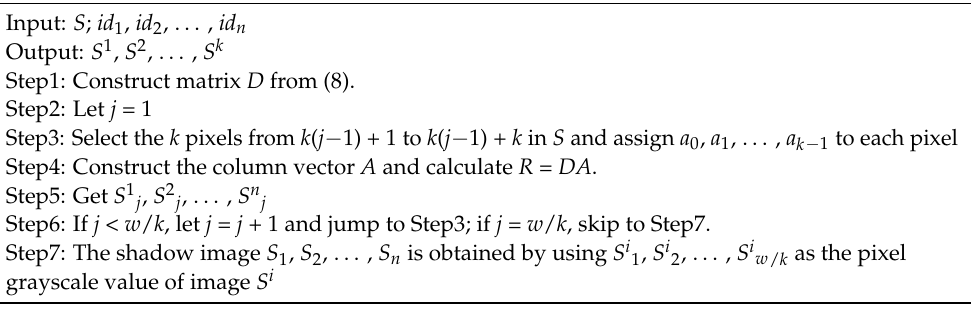
Algorithm 3 Image secret sharing algorithm based on matrix